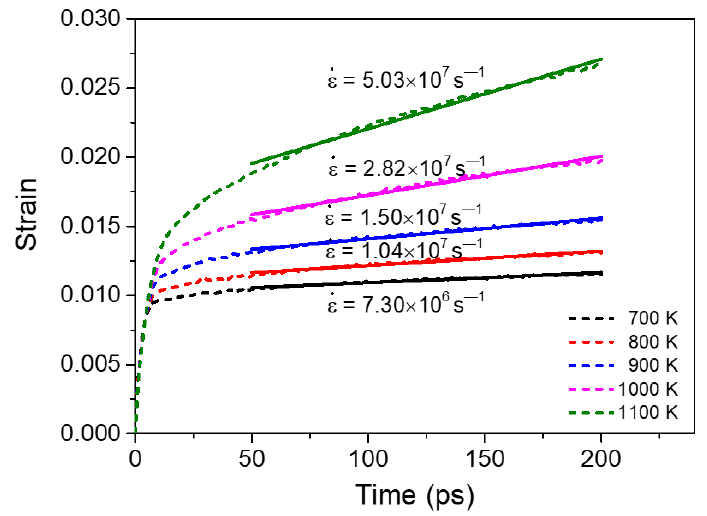
Figure 8. Creep curves of the segregated Ni-Mo (3 at.%) sample with d = 10.9 nm at different temperatures under an applied stress of 1.0 GPa.